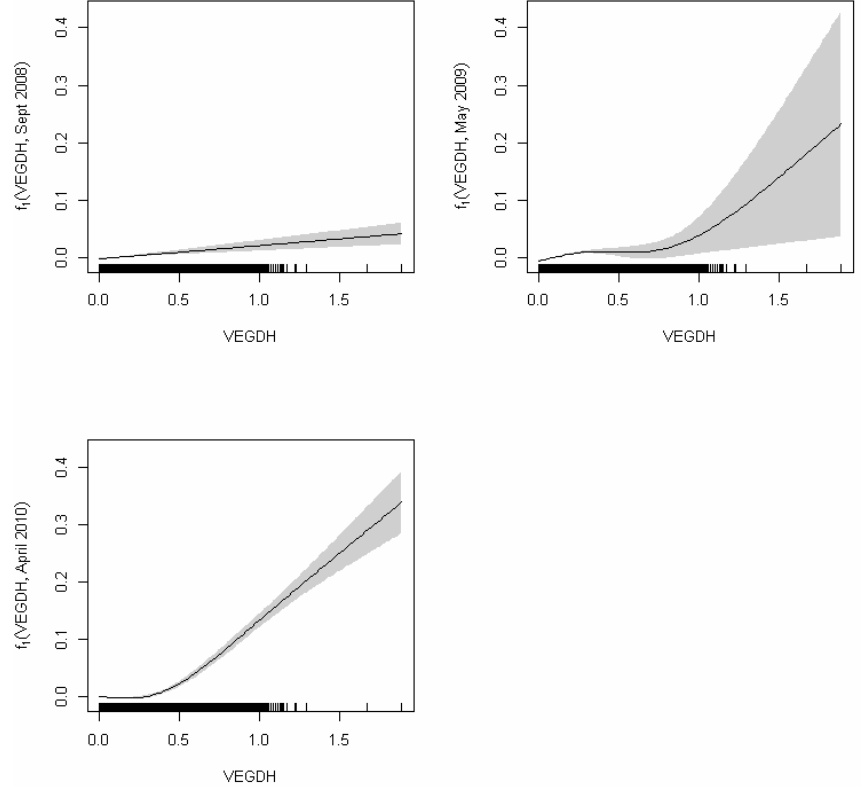
Fig. 9. Nonlinear effect of the product of vegetation density and vegetation height (VEGDH) at different times on the surface height change (DHEIGHT) (see Eq. 17). Shaded: 95%-confidence